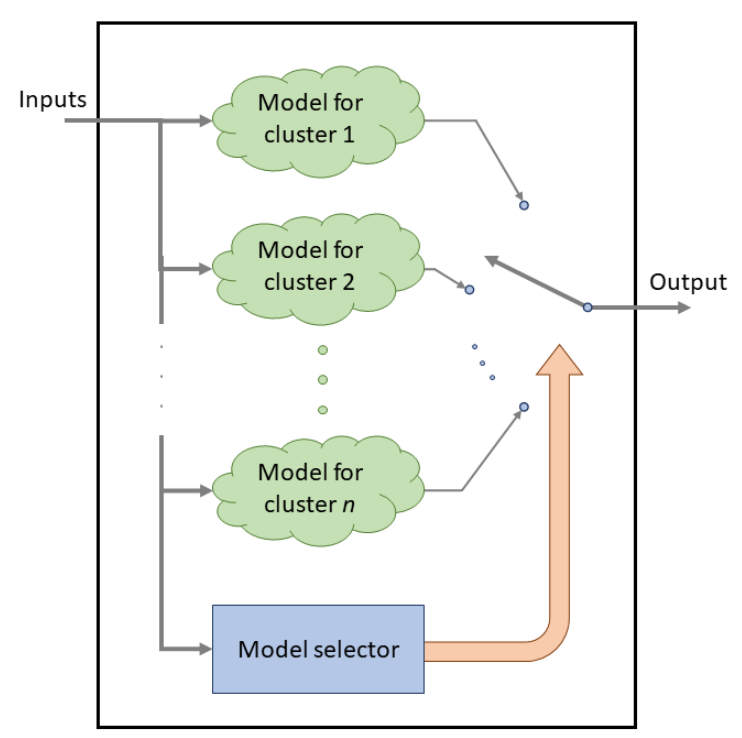
Figure 3. Internal layout for a hybrid